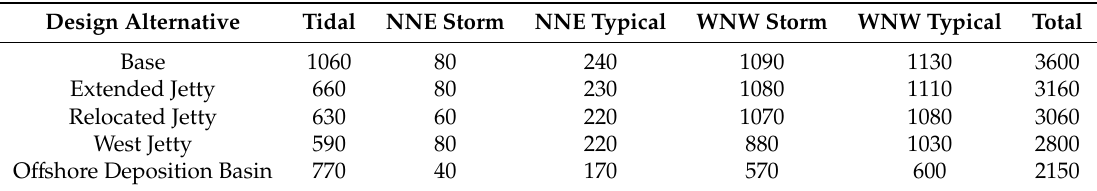
Table 8. Annualized fill volume estimate within channel limits (m 3 ).